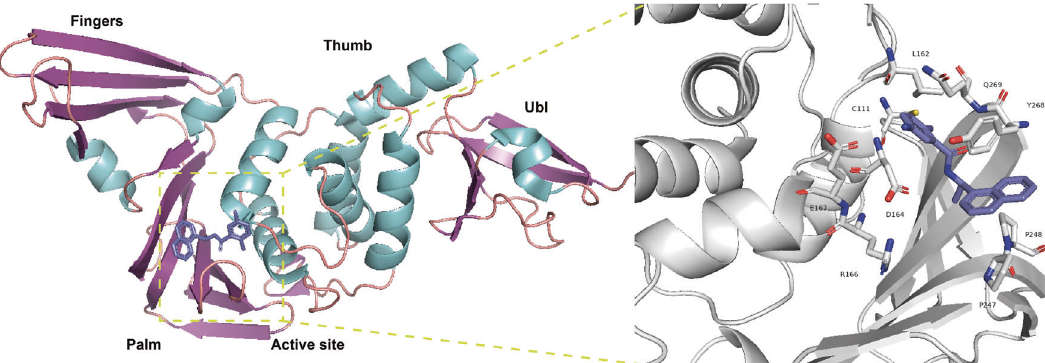
Fig. 5 Cartoon structure of SARS-CoV-2 PL pro in complex with GRL0617 (Protein Data Bank entry 7CJM) 112 and the key residues in the PL pro domain (Protein Data Bank entry 7JRN)